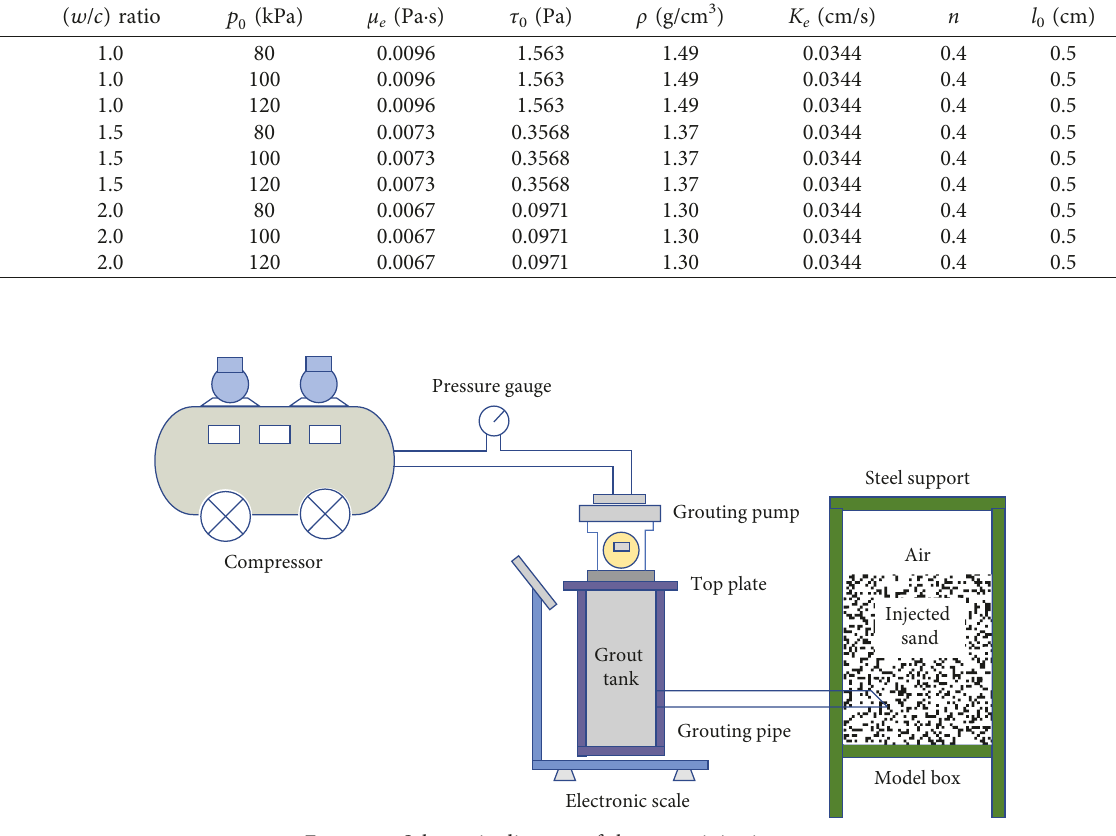
Figure 5: Schematic diagram of the grout injection